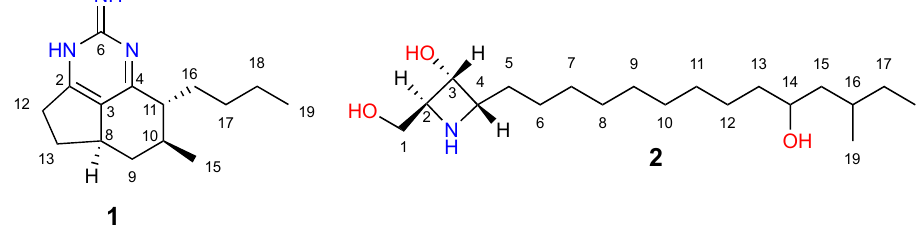
Figure 8. Chemical structure of compounds mirabilin B ( 1 ) and penaresidin B ( 2 ). Table 9. Experimental a and reported b 13 C NMR (125 MHz) data for mirabilin B ( 1 ) and penaresidin To confirm the presence of mirabilin B ( 1 ) and penaresidin B ( 2 ) (Figure 8) in the R4 sub-fraction, the carbon chemical shift signals of the 13 C NMR spectrum of this sub-fraction (see Supplementary Materials, Figures S4 and S6) were compared to those reported for these compounds in the literature, using a Pearson’s chi-squared goodness of fit test ( χ 2